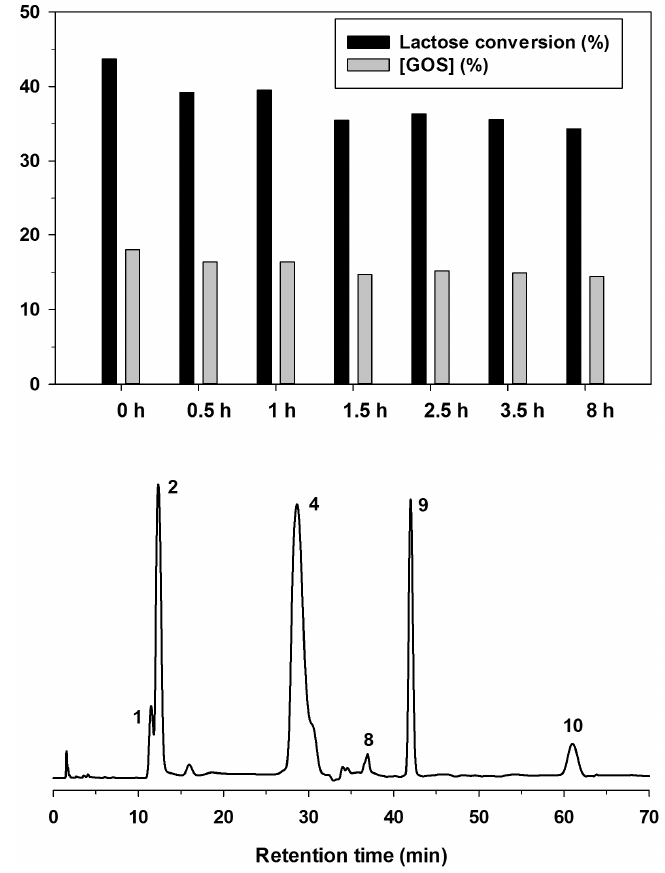
Figure 7. Top: Operational stability at 4 °C during the first 8 h of the PBR containing the β‐galactosidase from B. circulans immobilized in glyoxal agarose, using skim milk as feed solution. Bottom: HPAEC ‐ PAD analysis of the PBR outlet at 2.5 h The peaks correspond to: (1) Galactose; (2) Glucose; (4) Lactose; (8) Gal ‐β (1 → 3) ‐ Glc; (9) 4 ′‐ Galactosyl ‐ lactose; (10) Gal ‐β (1 → 4) ‐ Gal ‐β (1 → 4) ‐ Gal ‐ β (1 → 4) ‐ Glc.